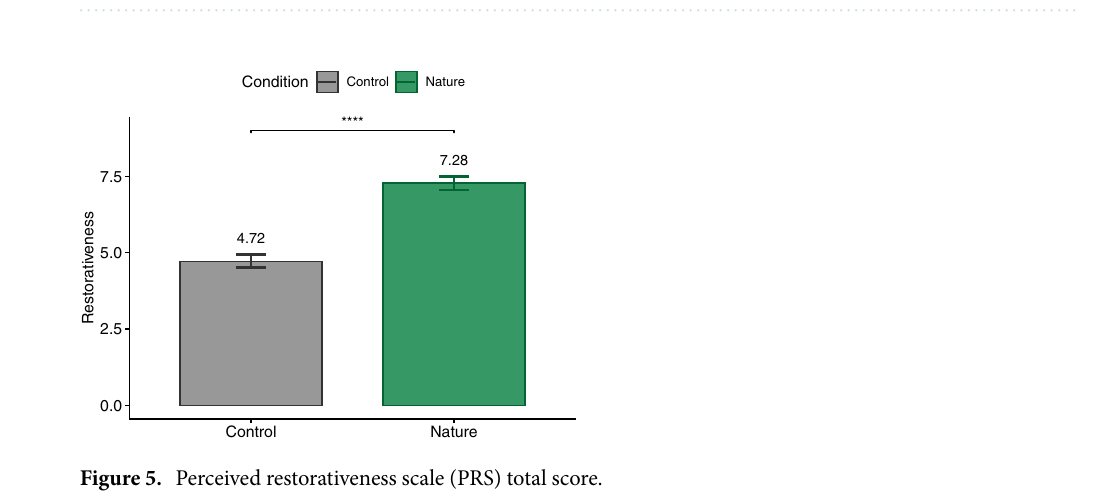
Figure 4. Digit span forward and backward (DSF/DSB) memory tests.